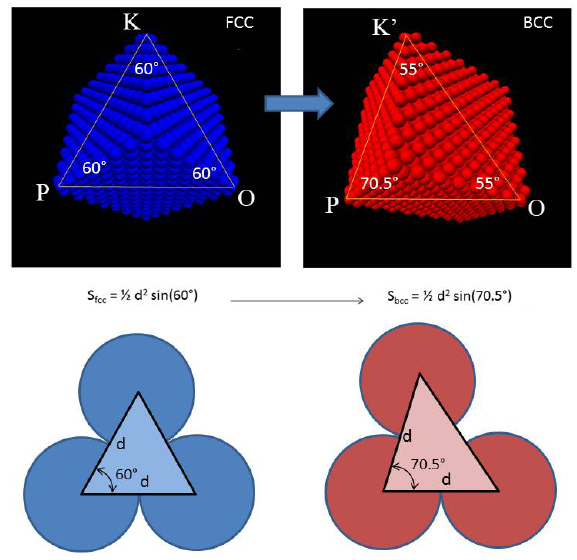
Figure 23. Representation of the fcc-bcc distortion with the KS OR. The volume change is entirely due to the angular distortion in the plane POK ⟶ POK’, for which β = ( PO , PK ) increases for 60° to 70.5°.